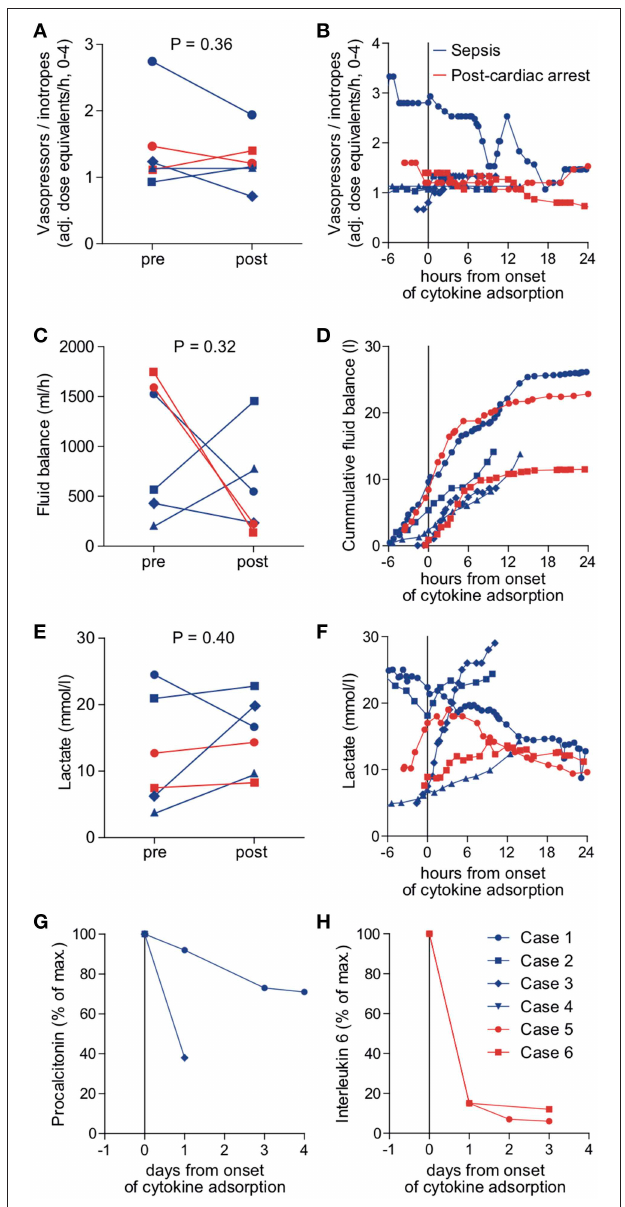
FIGURE 2 | Outcome parameters in patients undergoing cytokine adsorption during ECMO therapy. Mean vasopressor or inotropes use (A) , mean fluid balance per hour (B) and mean arterial lactate concentration as a surrogate parameter of shock (C) were determined within 24h before (pre) and after (post) onset of cytokine adsorption. The time courses of vasopressor or inotropes use (D) , fluid balance (E) and arterial lactate concentration (F) are depicted from 6h before to 24h after onset of cytokine adsorption (dashed line). Levels of procalcitonin in septic patients (G) or interleukin 6 in patients after cardiac arrest (H) were determined during 4 days after onset of cytokine adsorption. Blue circle, case 1; blue square, case 2; blue diamond, case 3; blue triangle, case 4; red circle, case 5; red square, case